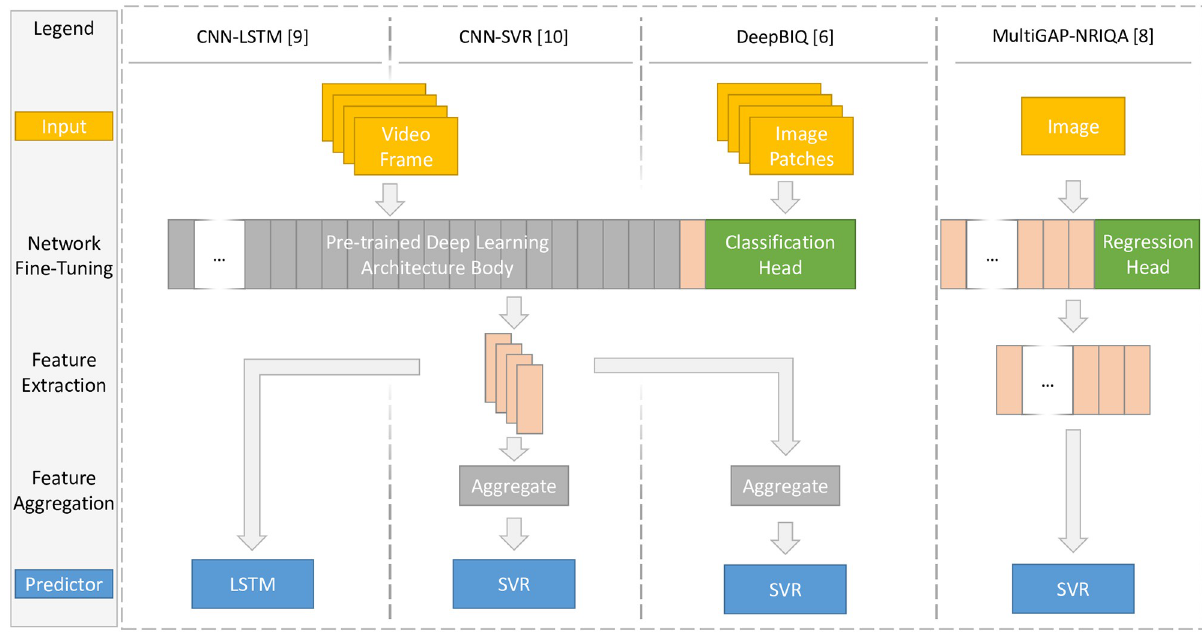
Fig 1. This is a high-level flowchart of the procedures employed in four of the five referenced visual quality papers. Video frames, image patches, or images are input into a pre-trained deep learning network with a classification or regression head replacement. The entire network is fined-tuned and then used as a feature extractor. The approaches differ by using the last layer or all layers as a feature source. The feature representations are then aggregated, where appropriate, and used to train the final quality